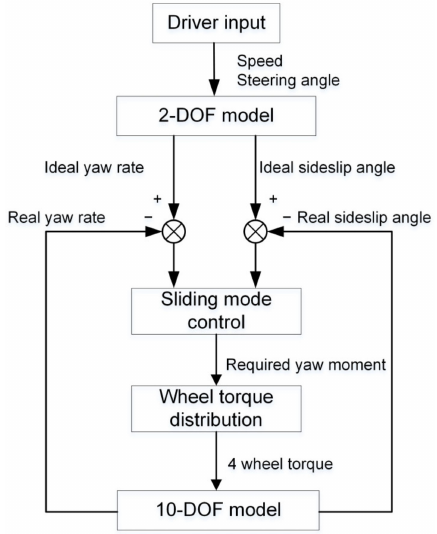
Figure 3. Flow chart of genetic sliding mode